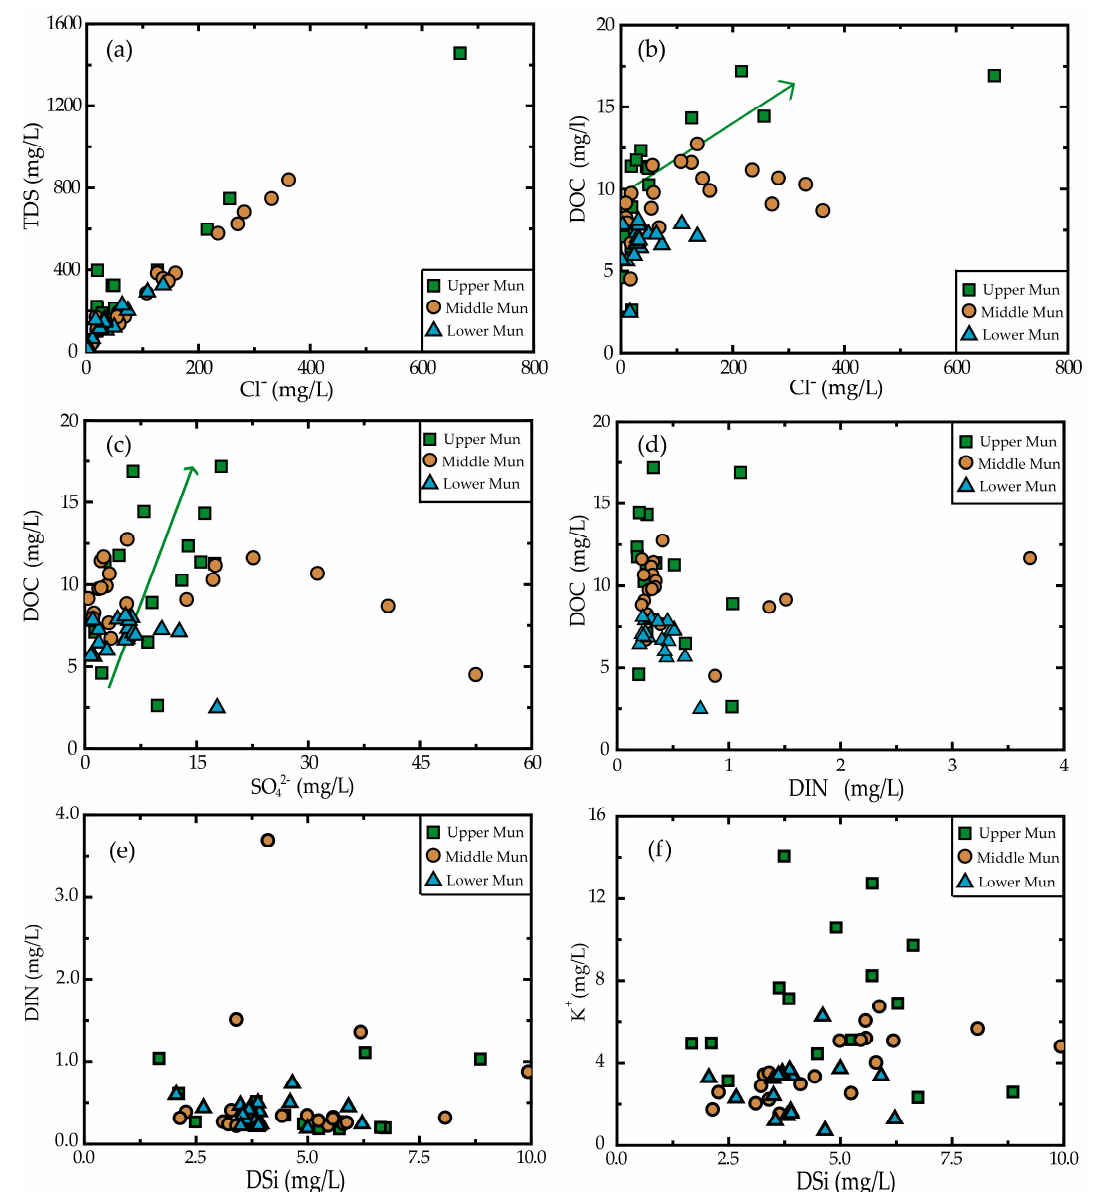
Figure 6. Relationships between the dissolved loads: ( a ) TDS vs. Cl − ; ( b ) DOC vs. Cl − ; ( c ) DOC vs. SO 42 − ; ( d ) DOC vs. DIN; ( e ) DIN vs. DSi; and ( f ) K + vs. DSi.